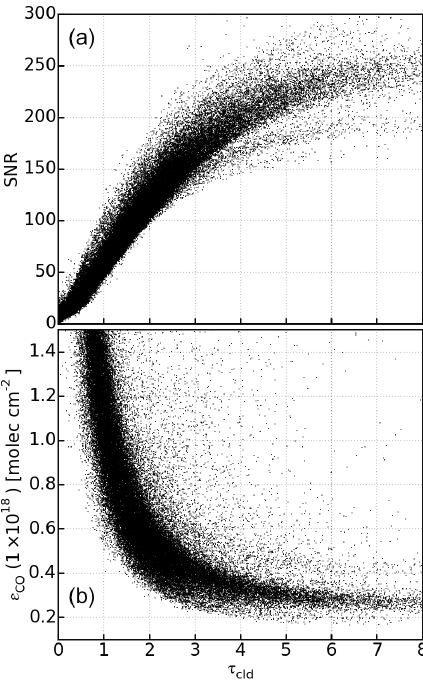
Figure 3. (a) SNR in the SCIAMACHY CO retrieval window. (b) CO retrieval error (cid:15) CO (as a function of the retrieved cloud optical thickness τ cld ). Data are shown for the year 2003 for a lati- tude/longitude box [(30 ◦ S, 30 ◦ W), (0 ◦ , 0 ◦ )] over the